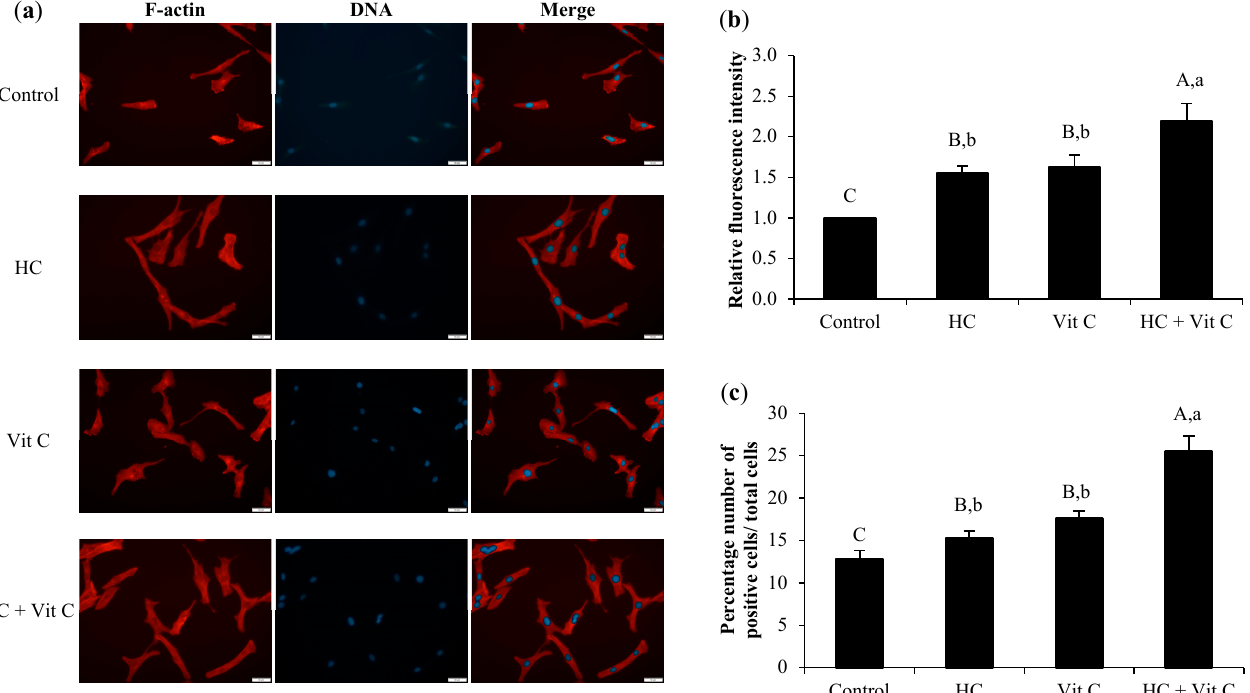
Figure 4. Effect of HC, Vit C, and HC combined with Vit C (HC+Vit C) at the selected levels on HDF migration at 0, 24, and 48 h. Cell morphology with a magnification of ×10 ( a ) and % wound area ( b ). Bars represent standard deviation ( n = 3 ). Different uppercase letters on bars indicate significant differences among different samples tested within the same time ( p < 0.05). Different lowercase letters on bars indicate significant differences between time tested within the same samples ( p < 0.05).